Question: Identify the chart type used in this figure.
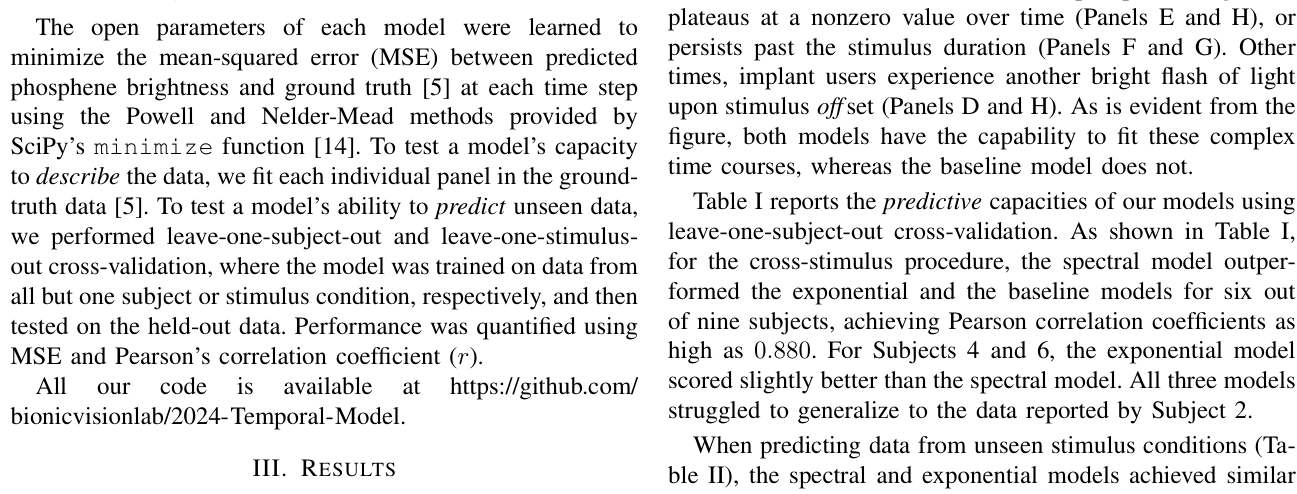
Answer: line